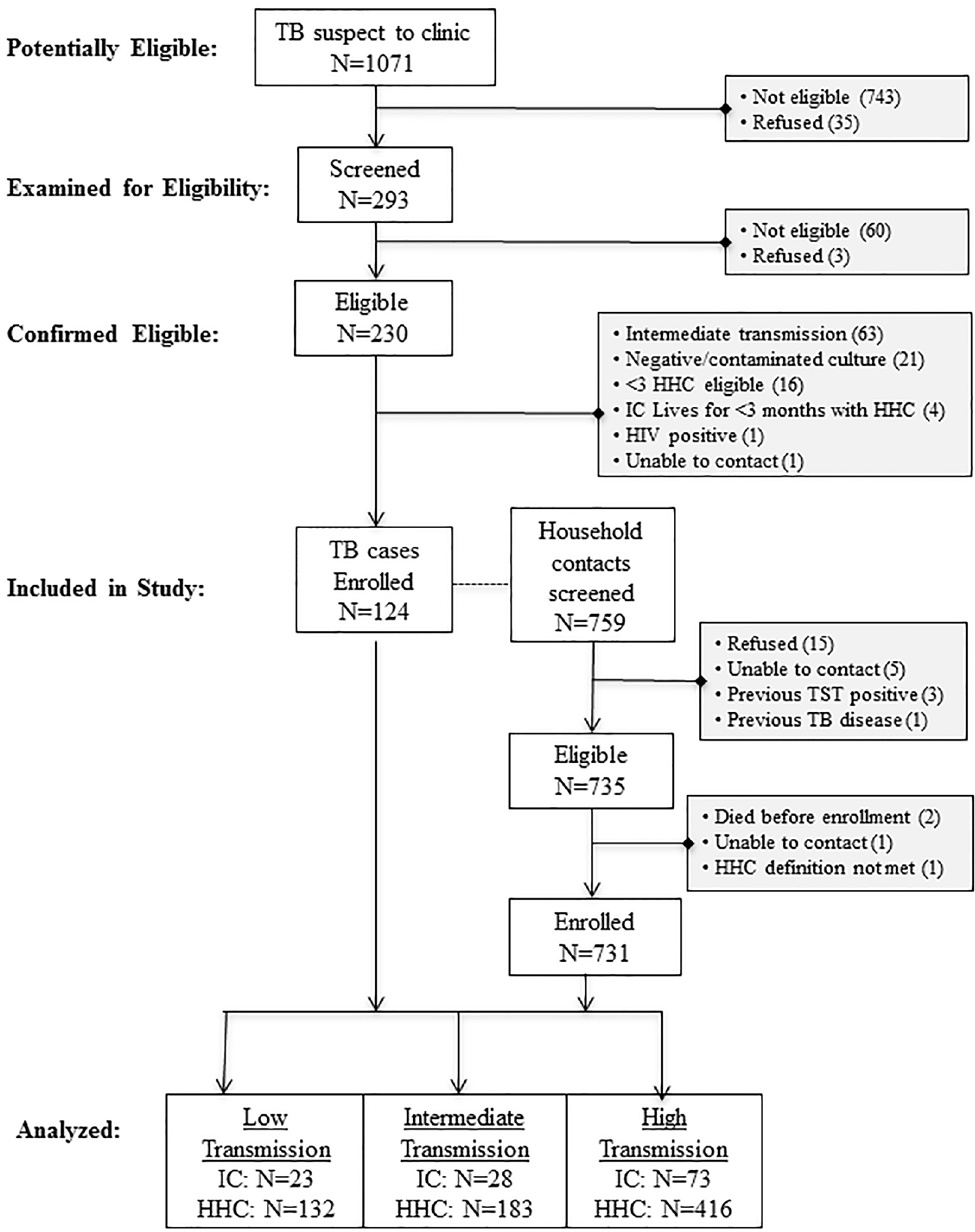
Figure 1. Study profile.